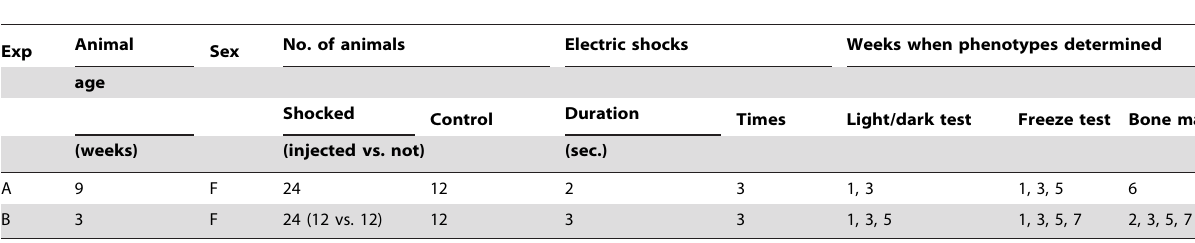
Table 1. Information regarding mice used, shock treatment, and phenotypes determined for each experiment.